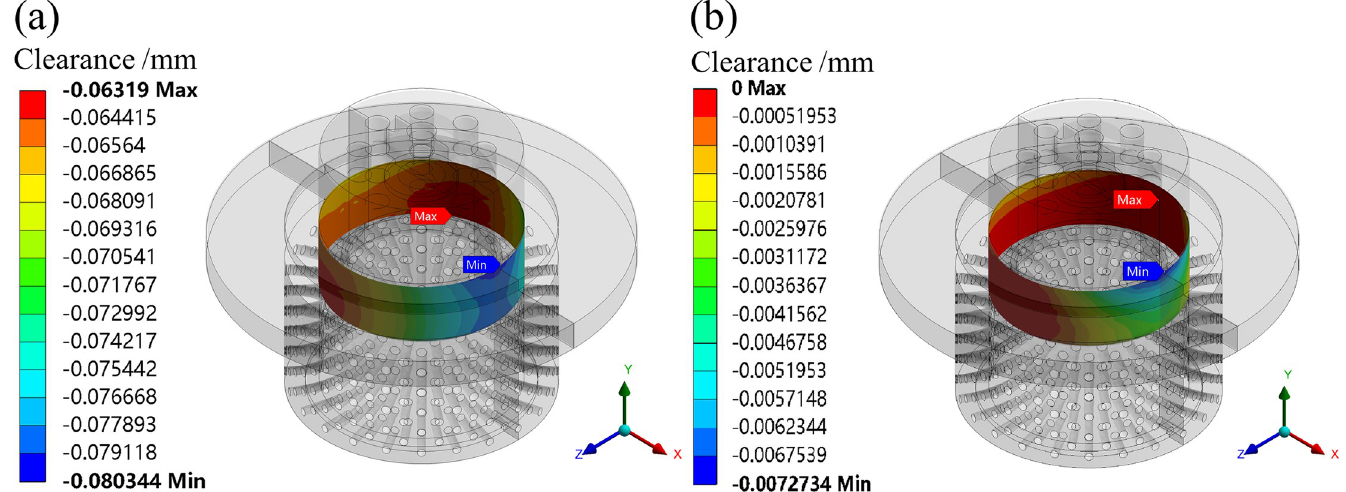
Fig 11. Clearances after deformation of the matching surface at a 100% opening. (a) Initial clearance: 0.073 mm. (b) Initial clearance: 0.010 mm.